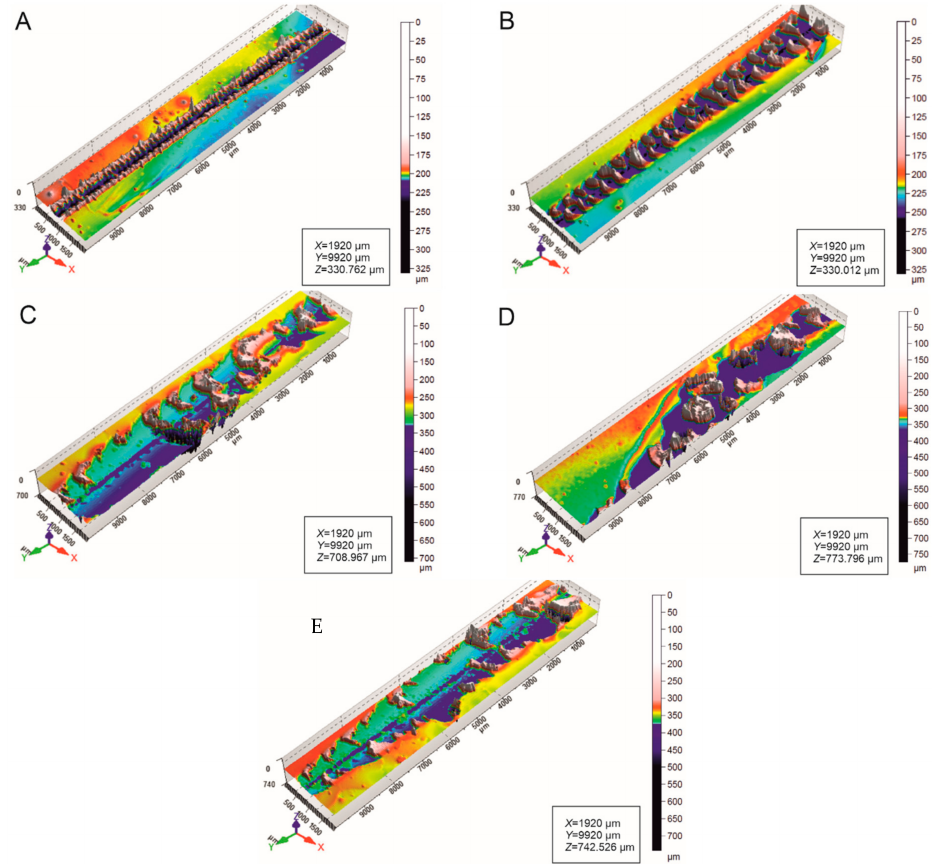
Figure 3. Three-dimensional (3D) reconstructed surfaces of scratch deformations on ( A ) Coat1, ( B ) Coat2, ( C ) Coat3, ( D ) Coat4, and ( E ) Coat5.